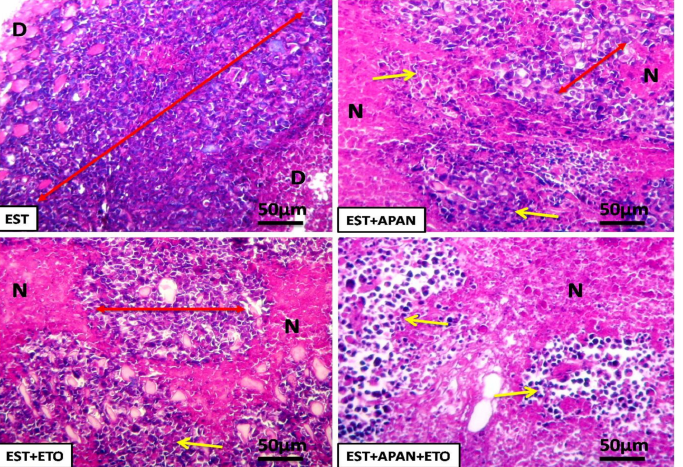
Figure 6. Light microscopic photomicrographs of H and E solid tumor sections of female mice in the different experimental groups. EST group shows hyperchromatic tumor cell populations (double-headed arrow) and irregular degenerated muscle fiber (D). EST mice treated with APAN or ETO reveal a moderate degree of improvement with the remaining tumor cell population (double- headed arrow), mild inflammatory cell infiltrations (thin arrows), and diffuse necrosis of skeletal muscle tissue (N). EST mice treated with both APAN+ETO reveal strong diffuse necrosis of skeletal muscle tissue (N) around the remaining tumor cells population (double-headed arrow) and marked inflammatory cell infiltrations (thin arrows). Scale bar, 50 µ